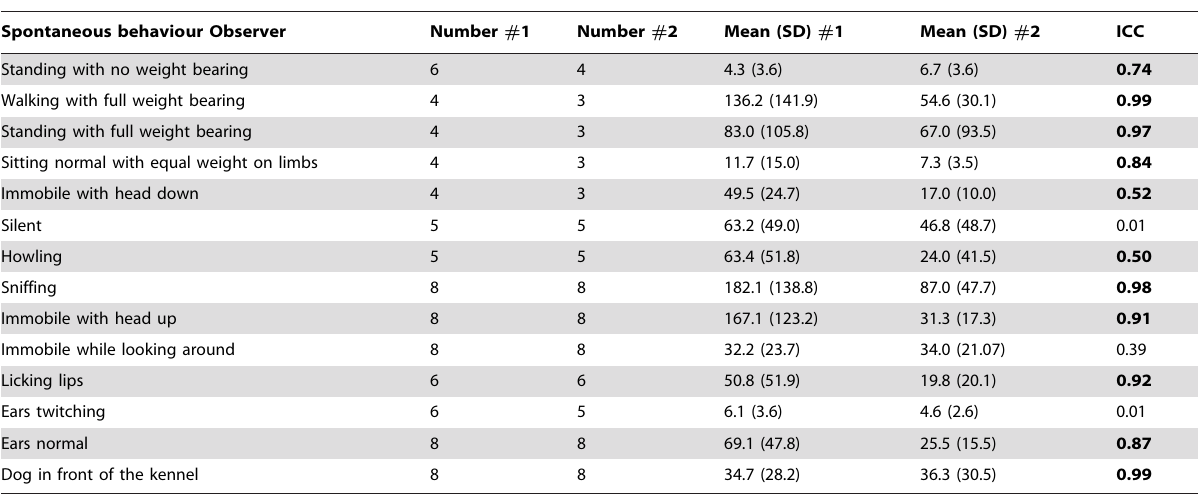
Table 1. Interobserver reliability of the video-analysis.